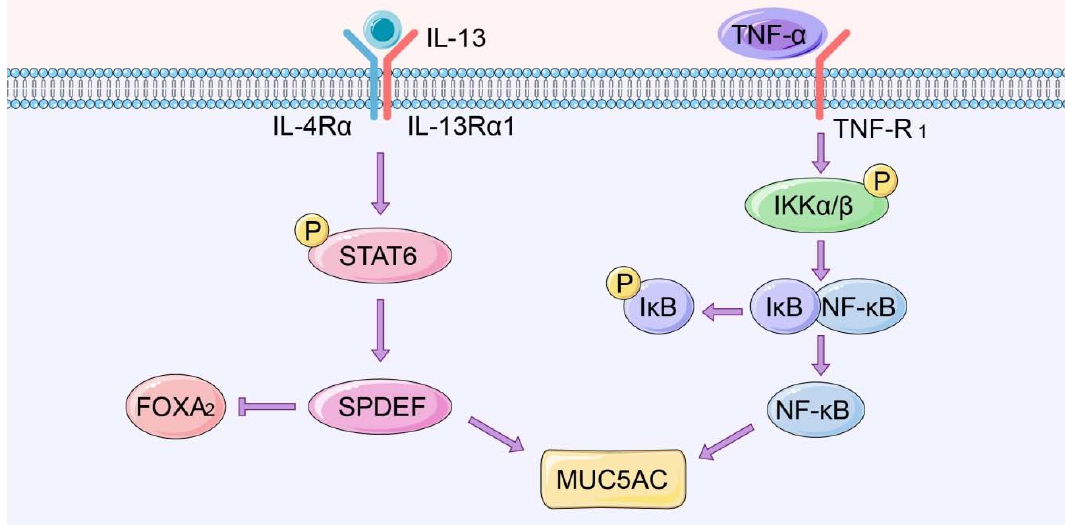
Figure 3. IL ‐ 13 ‐ STAT6 ‐ SPDEF and NF ‐κ B signaling pathways associated with mucus hypersecretion. Figure 3. IL-13-STAT6-SPDEF and NF- κ B signaling pathways associated with mucus